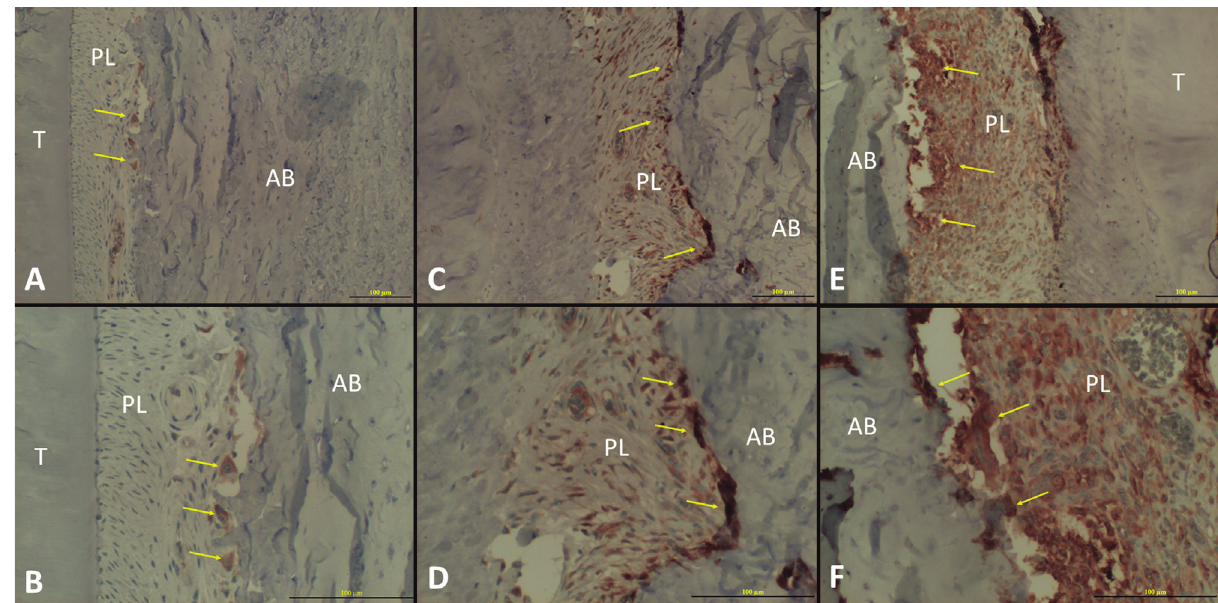
T=tooth; AB=alveolar bone; PL=periodontal ligament; NL=non-ligated; LO=ligature only; S=ligature and treated with Figure 4- Osteoprotegerin (OPG) expressions in NL, LO, and S groups. A- OPG expressions (yellow arrows) in NL group at 200x magnification; B- OPG expressions (yellow arrows) in NL group at 400x magnification; C- OPG expressions (yellow arrows) in LO group at 200x magnification; D- OPG expressions (yellow arrows) in LO group at 400x magnification; E- OPG expressions (yellow arrows) in S group at 200x magnification; F- OPG expressions (yellow arrows) in S group at 400x magnification